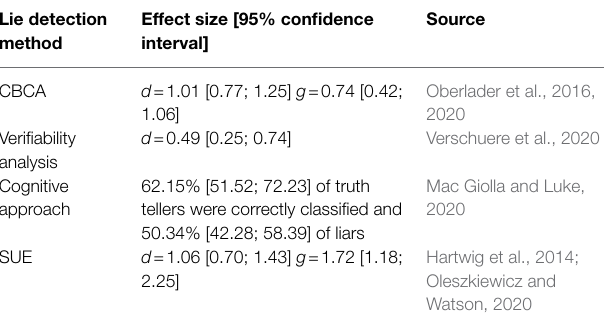
TABLE 1 | The effect sizes of lie detection